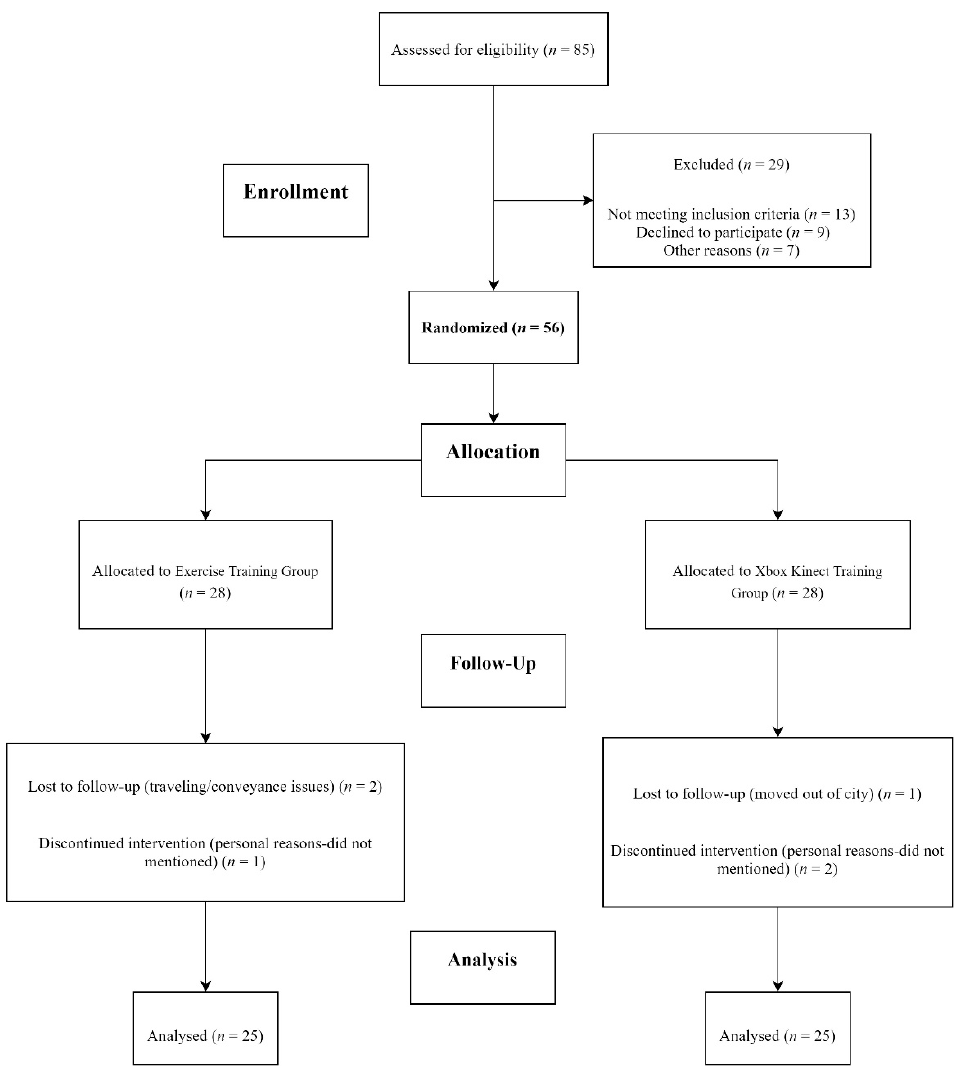
Figure 1. CONSORT 2010 flow diagram.